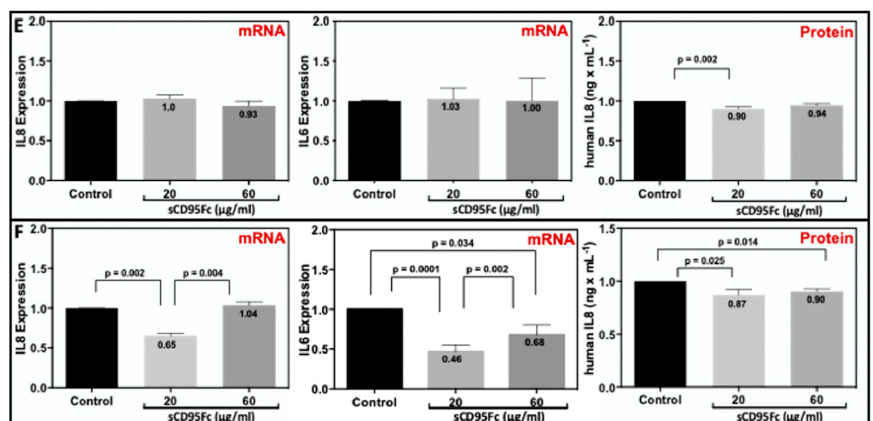
Figure 7. Inhibitory effects of sCD95Fc on IL8 and IL6 mRNA and protein expression in pancreatic cancer cell lines upon TNF α , TRAIL and rCD95L treatment. Human pancreatic cancer cells PancTuI-luc ( A ) and A818-4 ( B ) were seeded with 2.8 × 10 5 cells/well in 6-well plates. Cells were either left untreated as control (black bar) or stimulated with 50 ng/mL TNF- α or 50 ng/mL TRAIL or 100 ng/mL rCD95L (grey bar), TNF- α ± sCD95Fc (20 μ g/mL) or TRAIL ± sCD95Fc (20 μ g/mL) or rCD95L ± sCD95Fc (20 μ g/mL) (dark grey) and TNF- α ± sCD95Fc (60 μ g/mL) or TRAIL ± sCD95Fc (60 μ g/mL) or rCD95L ± sCD95Fc (60 μ g/mL) (light grey) for 36 h. Cells were lysed in RNA Lysis Buffer T; total RNA was isolated, and assayed for IL8 (upper) and IL6 (lower) by PerfectProbe RT-PCR assays ( A , B ). Relative expression was normalized to the control and reference genes UBC or RPL13A and expressed as arbitrary unit (AU). ( C , D ) After the indicated time point (36 h), cell supernatants of PancTuI-luc ( C ) and A818-4 cells ( D ) was collected and centrifuged at 14,000 rpm at 4 °C for 15 min in an Eppendorf centrifuge to remove debris and dead cells and cleared supernatants were further analyzed by using a human IL8 ELISA. PancTuI-luc ( E ) and A818-4 ( F ) cells were treated with sCD95Fc (20 μ g/mL) (light grey) or (60 μ g/mL) (dark grey) for 36 h and then IL8 mRNA (left and middle panel) and IL8 protein (right panel) were analyzed. Controls were set as 1 in each experiment and the normal distribution of the data was tested by Shapiro–Wilk method. In case of significance, p -values were indicated. Data represent means ± SEM of biological replicates ( n = 3).